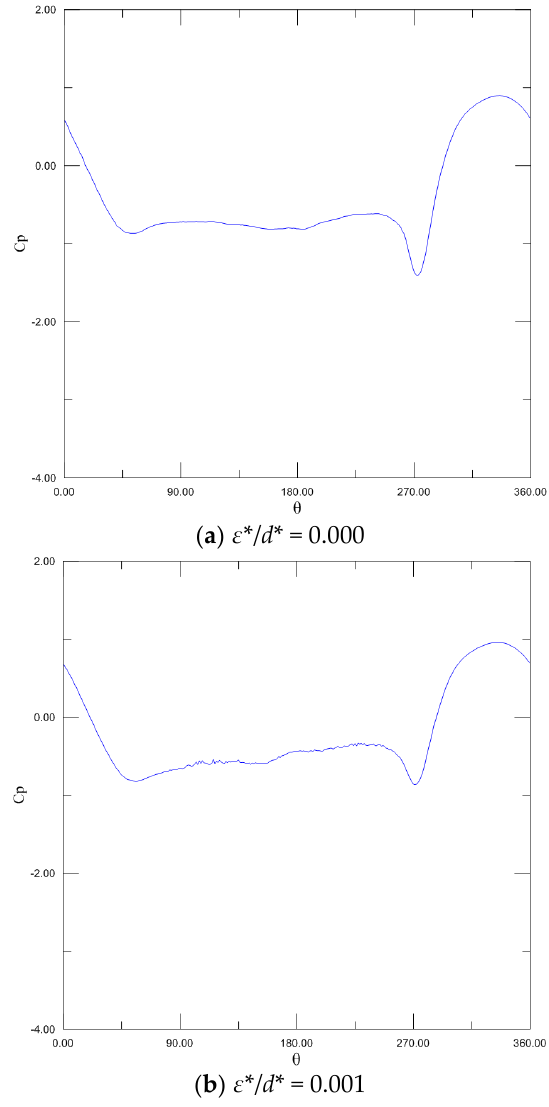
Figure 11. Time-averaged pressure distributions for the circular cylinder in the vicinity of a moving wall ( h */ d * = 0.05; Re = 1.0 × 10 5 ).